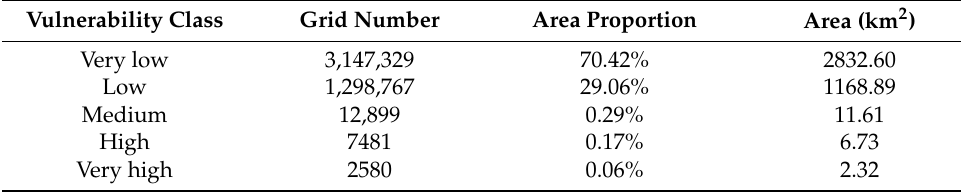
Table 8. Statistical result of landslide vulnerability in different